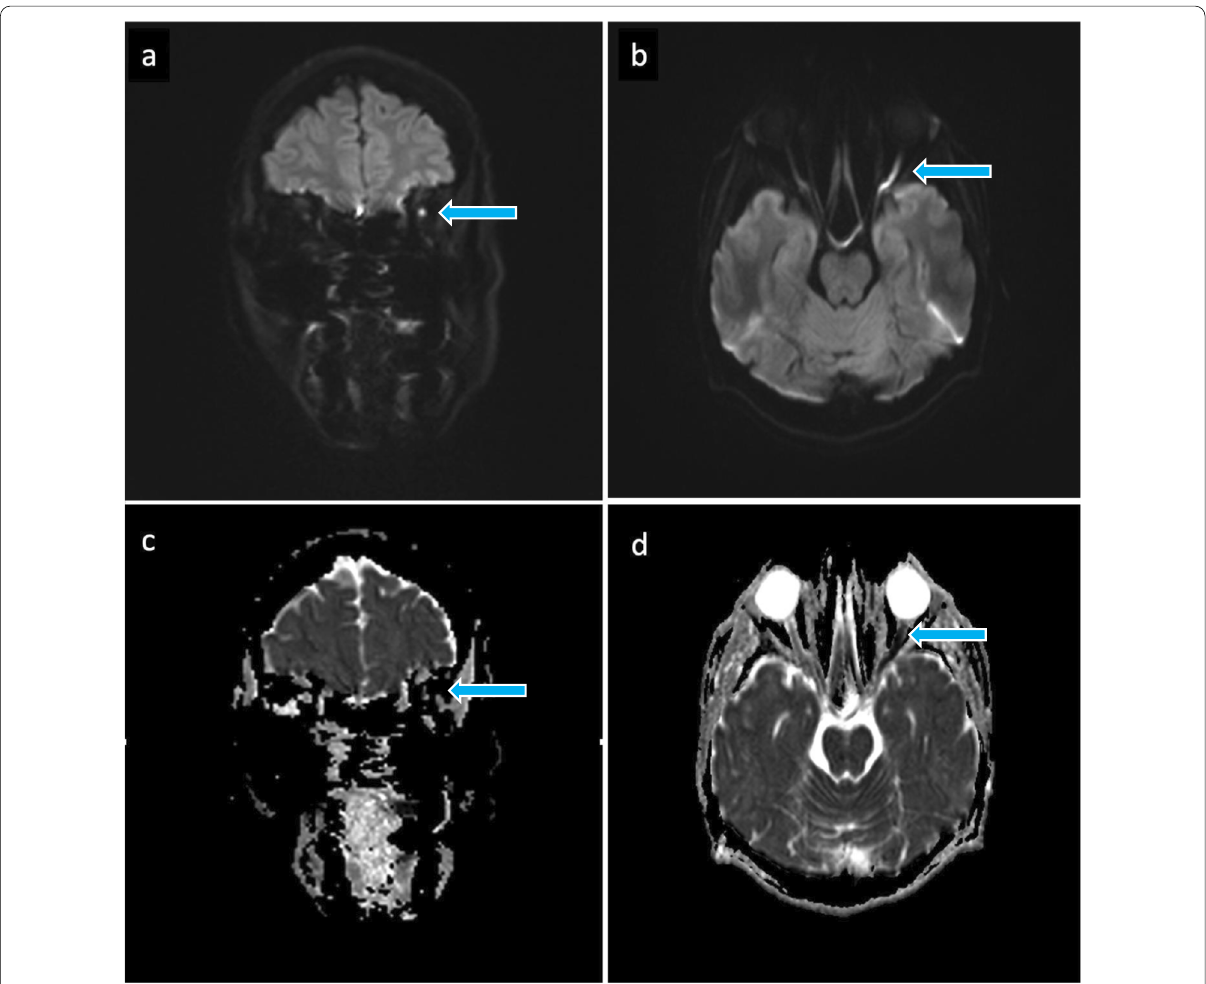
Fig. 4 MRI of the brain two months after the HA filler injection. Coronal ( a ) and axial ( b ) diffusion weighted imaging (DWI) b corresponding apparent diffusion coefficient (ADC) maps ( c, d ) corresponding to stable MRI